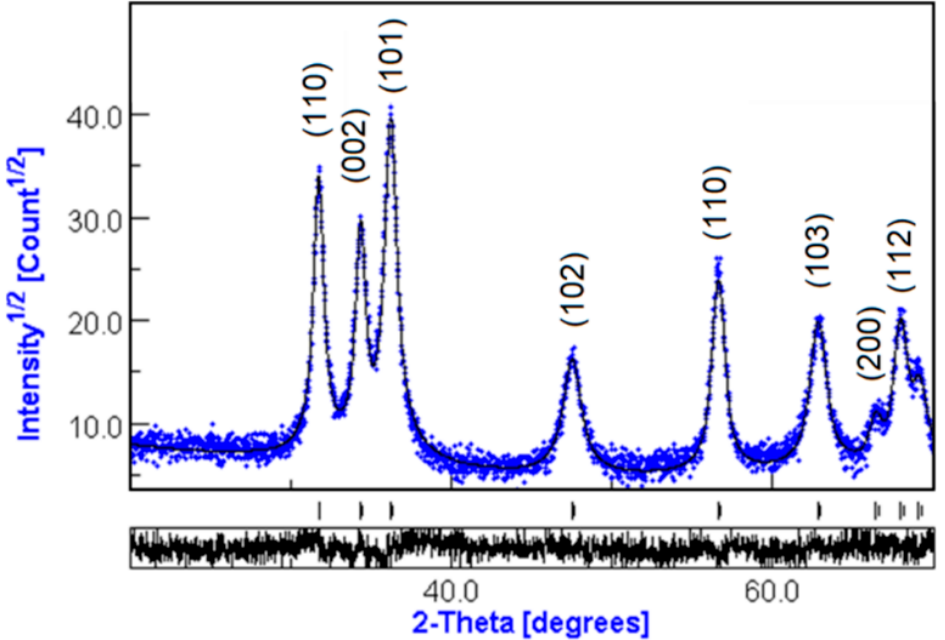
Figure 1. X-ray diffraction of ZnO nanopowders.